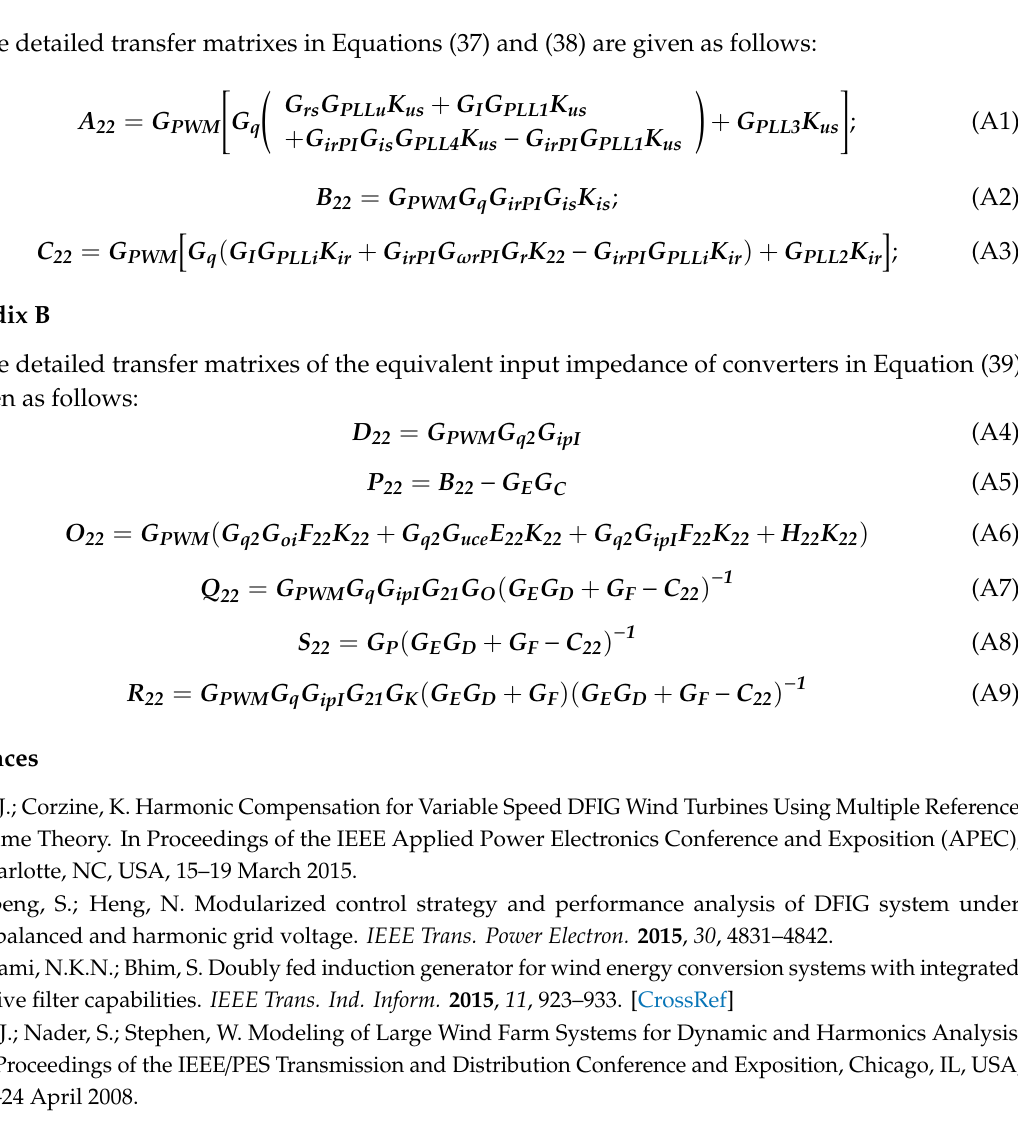
Figure A2. The small-signal transfer diagram of GSC with PLL.